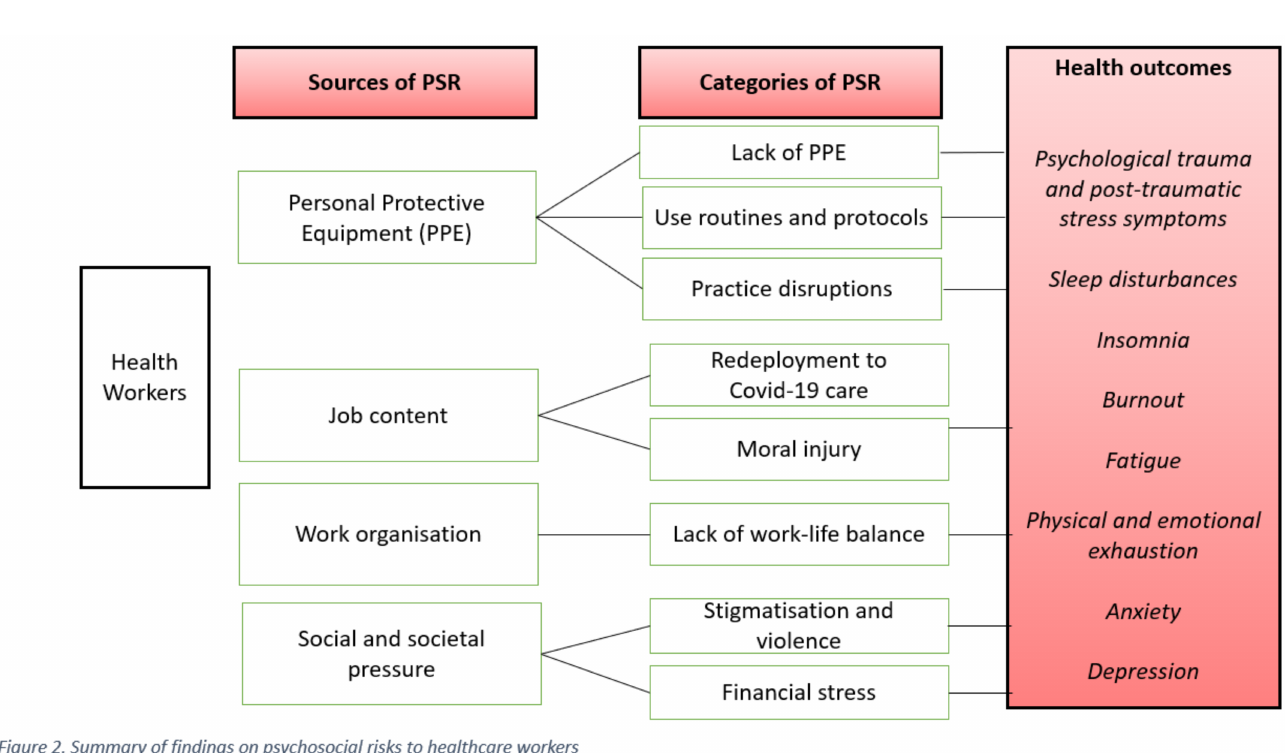
Figure 2. Summary of findings on psychosocial risks to healthcare